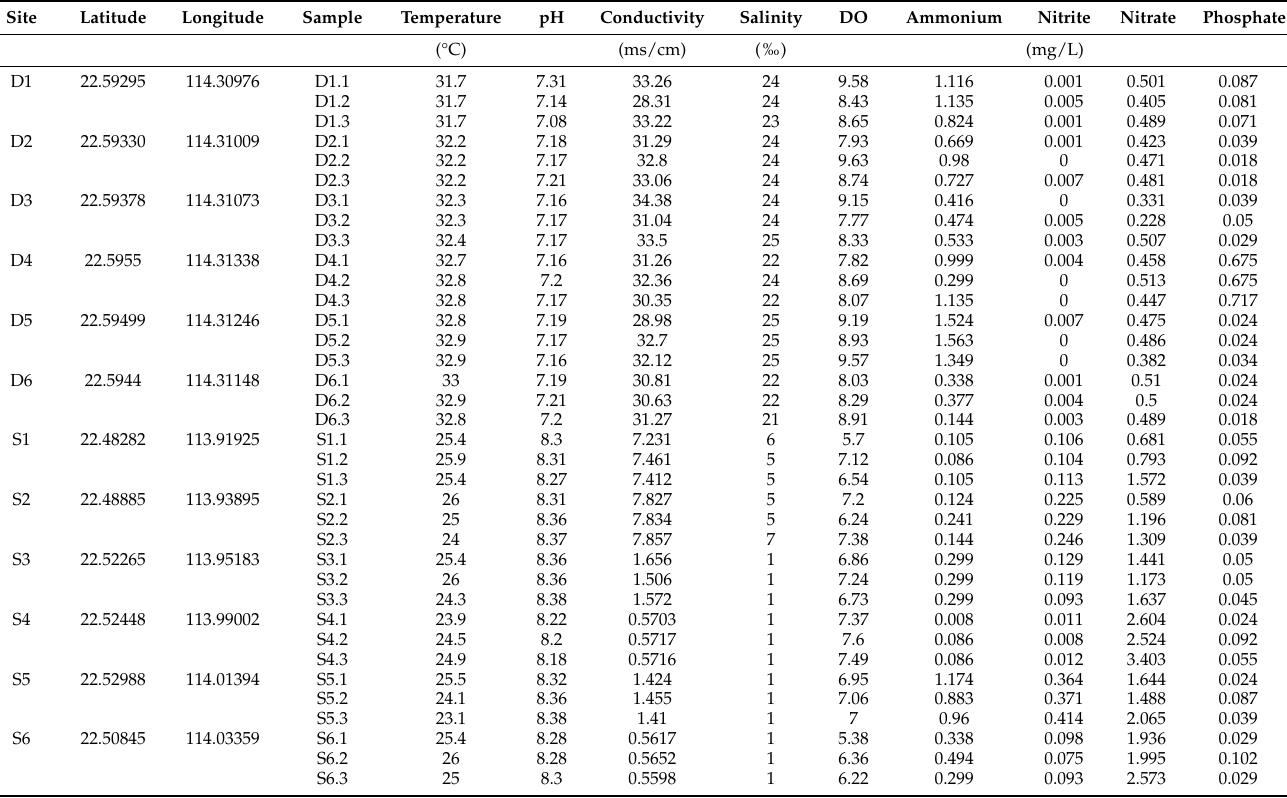
Table 1. Sampling sites and characteristics of the seawater